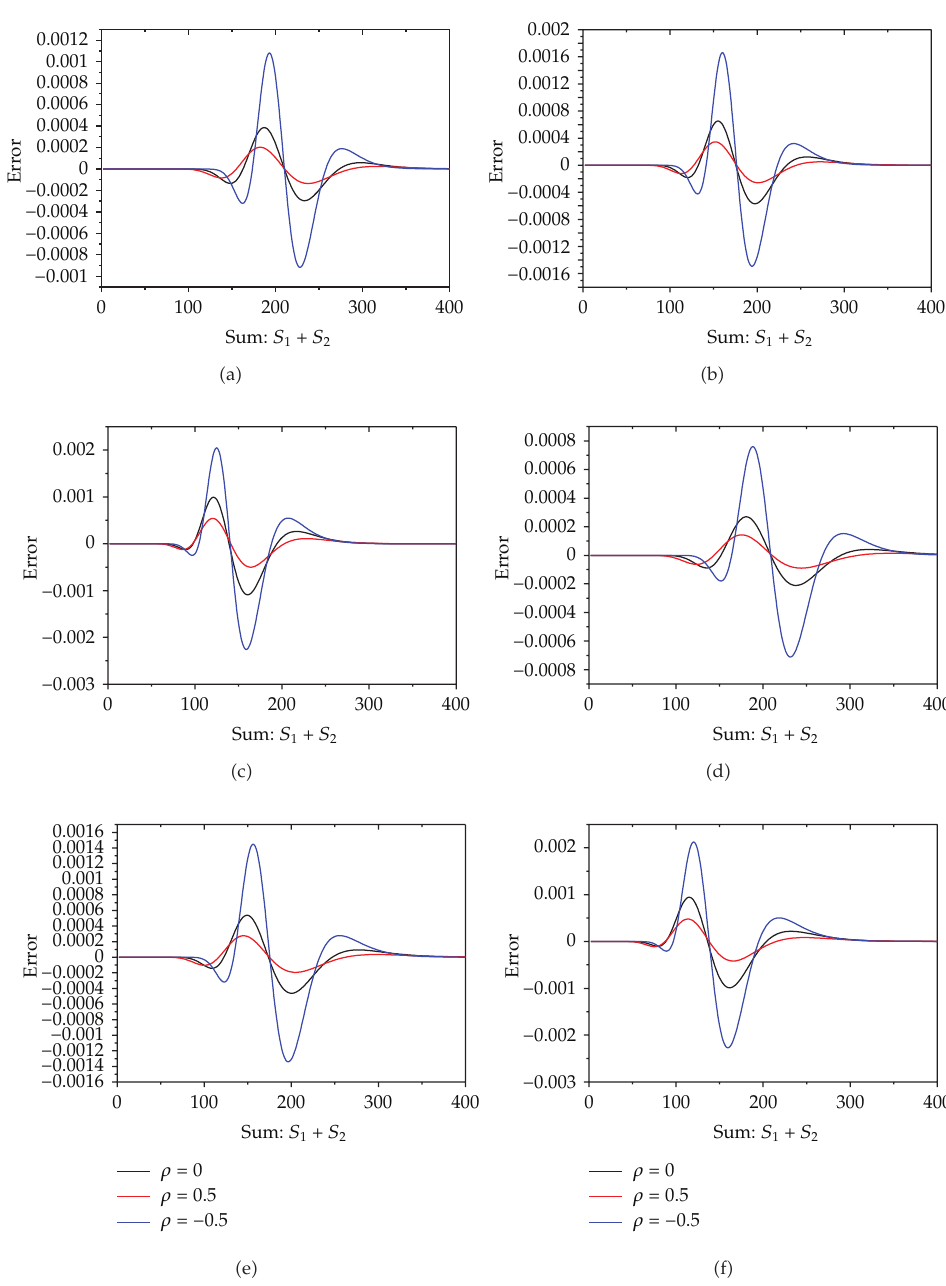
Figure 2: Error versus S 1 (cid:8) S 2 : The error is calculated by subtracting the approximate estimate from the exact result. (cid:3) a (cid:4) S 10 (cid:7) 110, S 20 (cid:7) 100, σ 1 (cid:7) 0 . 25, and σ 2 (cid:7) 0 . 15; (cid:3) b (cid:4) S 10 (cid:7) 110, S 20 (cid:7) 70, σ 1 (cid:7) 0 . 25, and